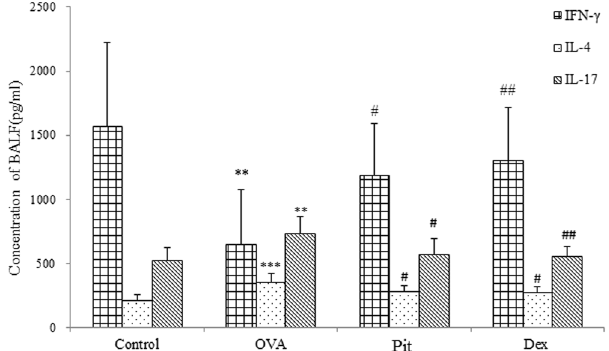
Figure 6. IL-4, IL-17, and IFN- γ levels in the BALF of mice treated with PBS, pitavastatin, or dexamethasone. Bronchoalveolar lavage samples were collected at 30 min after the last ovalbumin challenge. Control: Mice treated with aerosolized PBS. OVA: Mice challenged with OVA and treated with PBS. The numbers of goblet cells in the airway epithelia of these mice were significantly increased compared with those in the airway epithelial of control mice. Pit: Mice challenged with OVA and treated with inhaled pitavastatin. Dex: Mice challenged with OVA and treated with i.p. injections of dexamethasone. Values are expressed as the mean ± SD (n = 8 ‒ 10 per group). *** P < 0.001 compared with the control group; # P < 0.01 compared with the OVA group; ## P < 0.05 compared with the OVA group.